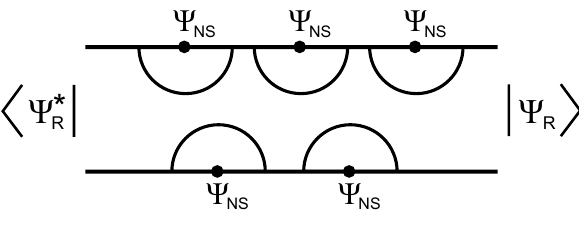
Figure 1 . A possible example for the analog of the generating function in open super string field theory. We represent it as a strip with string fields Ψ R in the Ramond sector as in and out states. Fields in the Neveu Schwarz sector are inserted using vertex operators Ψ NS